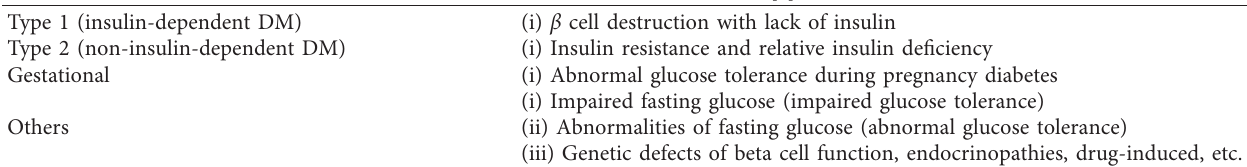
Table 5: Classification of diabetes